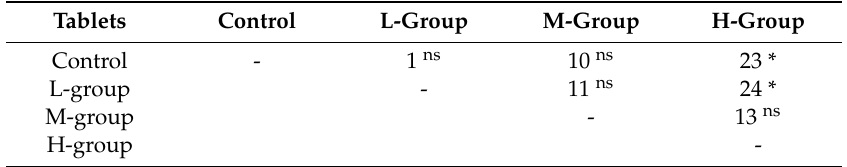
Table 8. Results of the preference ranking test of the lactobacilli e ff ervescent tablets supplemented with di ff erent contents of Chinese ginseng and Polygonatum sibiricum.